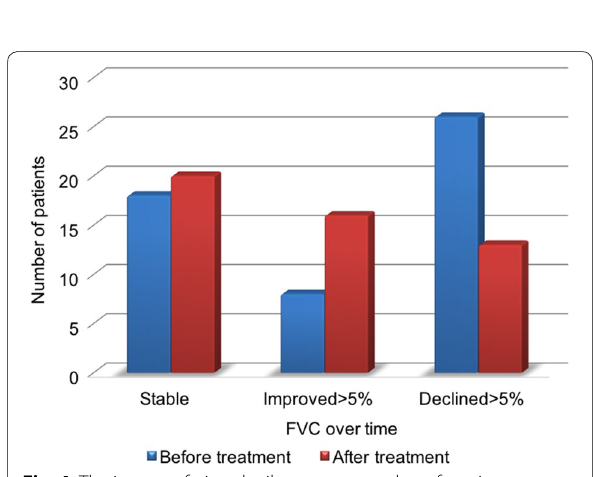
Fig. 4 The impact of nintedanib treatment on lung